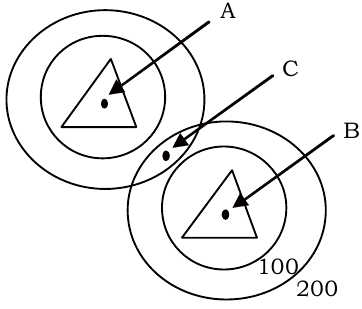
Figure 3. Agglomeration in Weber